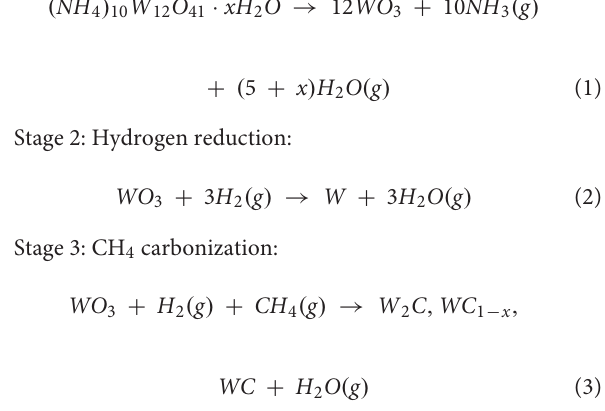
reaction of WO 3 generates these Magneli phases. Magneli- phase WO 3 is reduced to elemental W by graphite when the temperature is 599–794 ◦ C. X-ray diffractometry (XRD) of the samples was carried out at 741 ◦ C, and only the